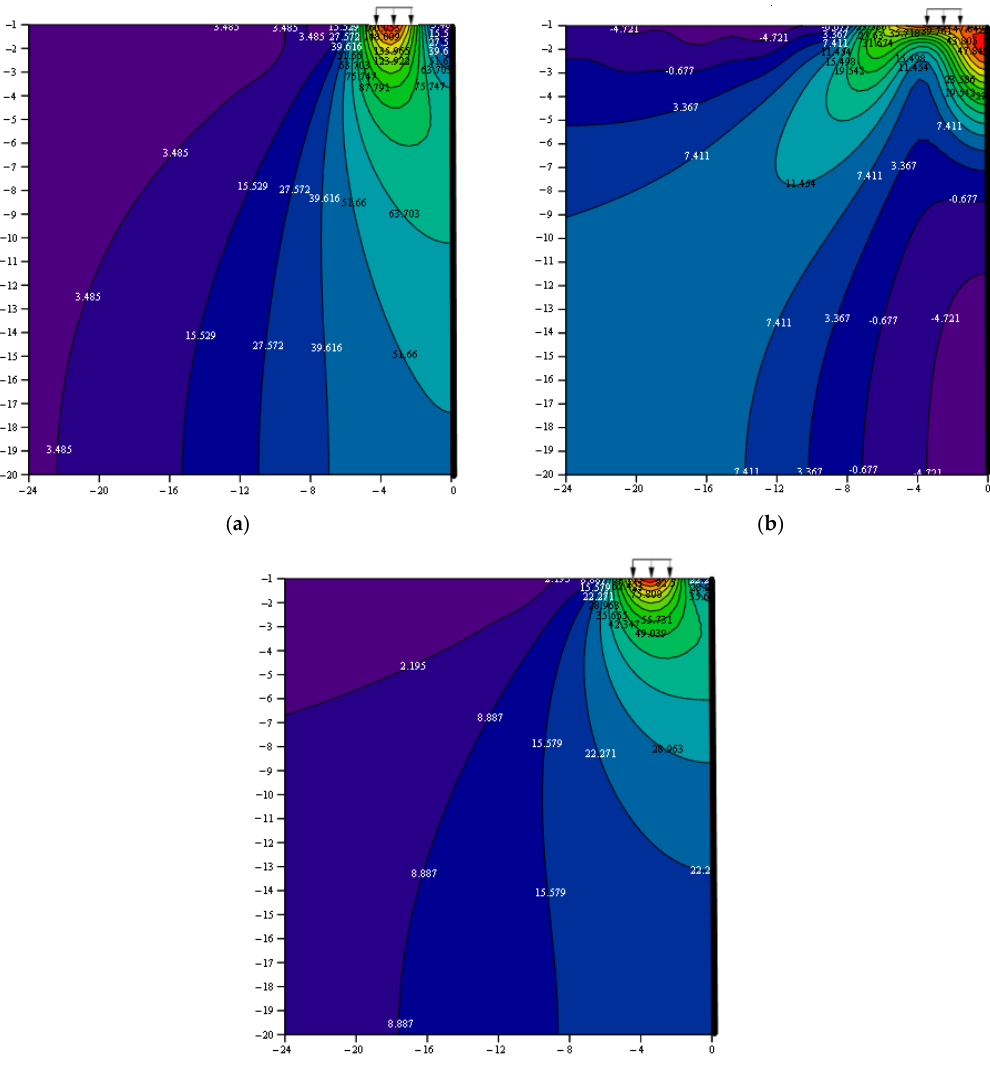
Figure 4. Stress isopoles at q = 100 kPa, d 2 = 2 m, and b = 2 a = 3 m: ( a ) vertical stress σ y ; ( b ) horizontal stress σ x ; ( c ) mean stresses σ m .